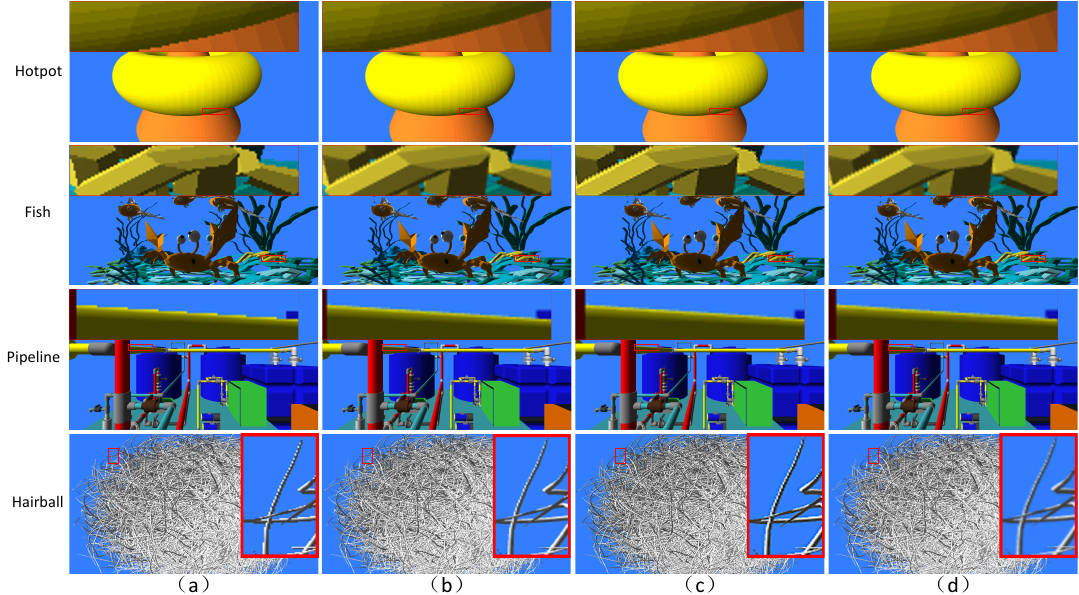
Figure 9. The different anti-aliasing algorithms. The complexity of the scene is sorted from low to high, ranking Hotpot (Tri:20,190), Fish (Tri:66,694), Pipeline (Tri:83,746), and Hairball (Tri:2,880,000). ( a ) is no anti-aliasing (AA), ( b ) is DSM, ( c ) is the simple discontinuity method, and ( d ) is our algorithm.